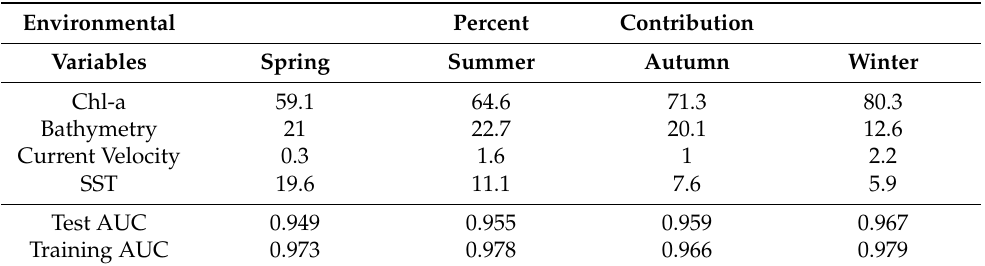
Table 2. Relative contribution of environmental variables used to construct habitat model by season. Environmental